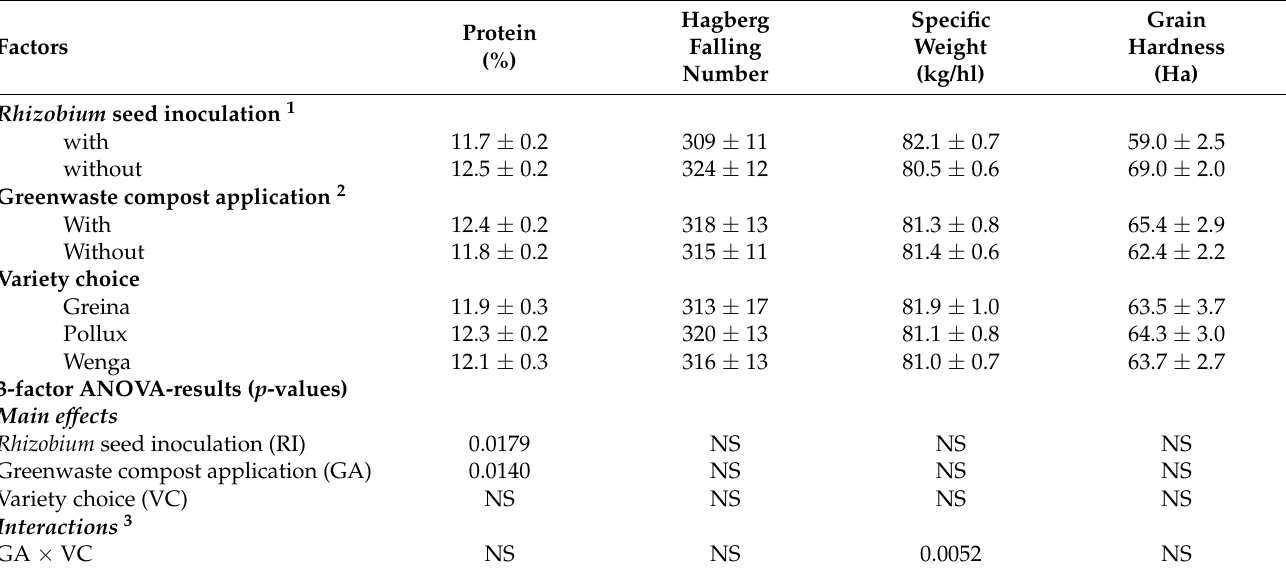
Table 7. Effect of clover ley management ( Rhizobium inoculation of clover seed and greenwaste compost applications) on grain quality performance parameters (protein concentration, Hagberg falling number, specific weight and grain hardness) in contrasting winter wheat varieties established after two-year clover leys. Values shown are main effect means ±